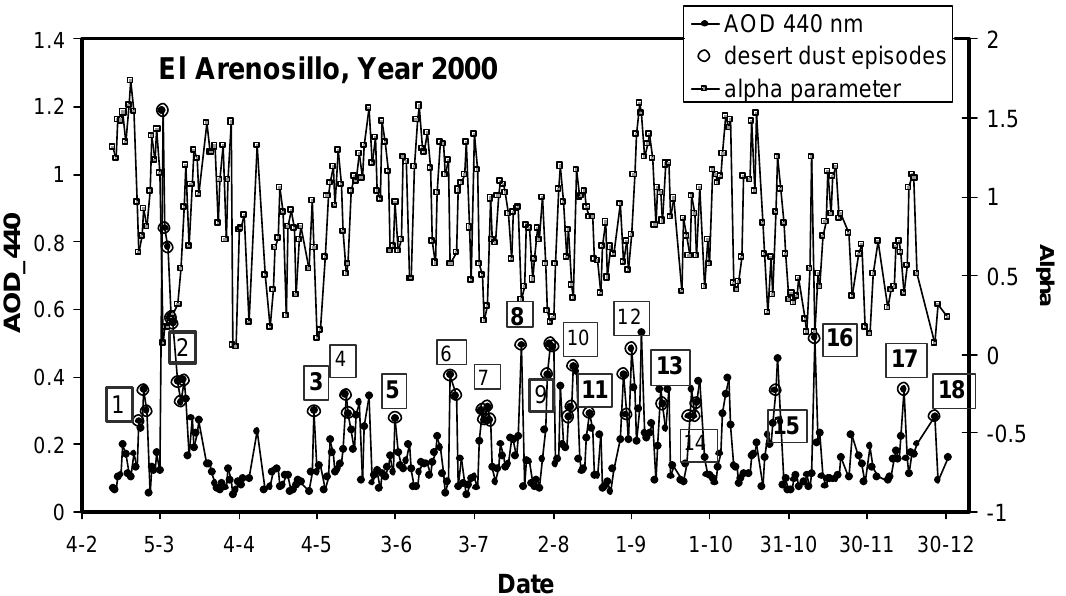
Fig. 4. Average daily values for AOD at 440nm and the α parameter evaluated by Cimel AERONET during year 2000 at El Arenosillo. The numbered episodes correspond to those determined by manual